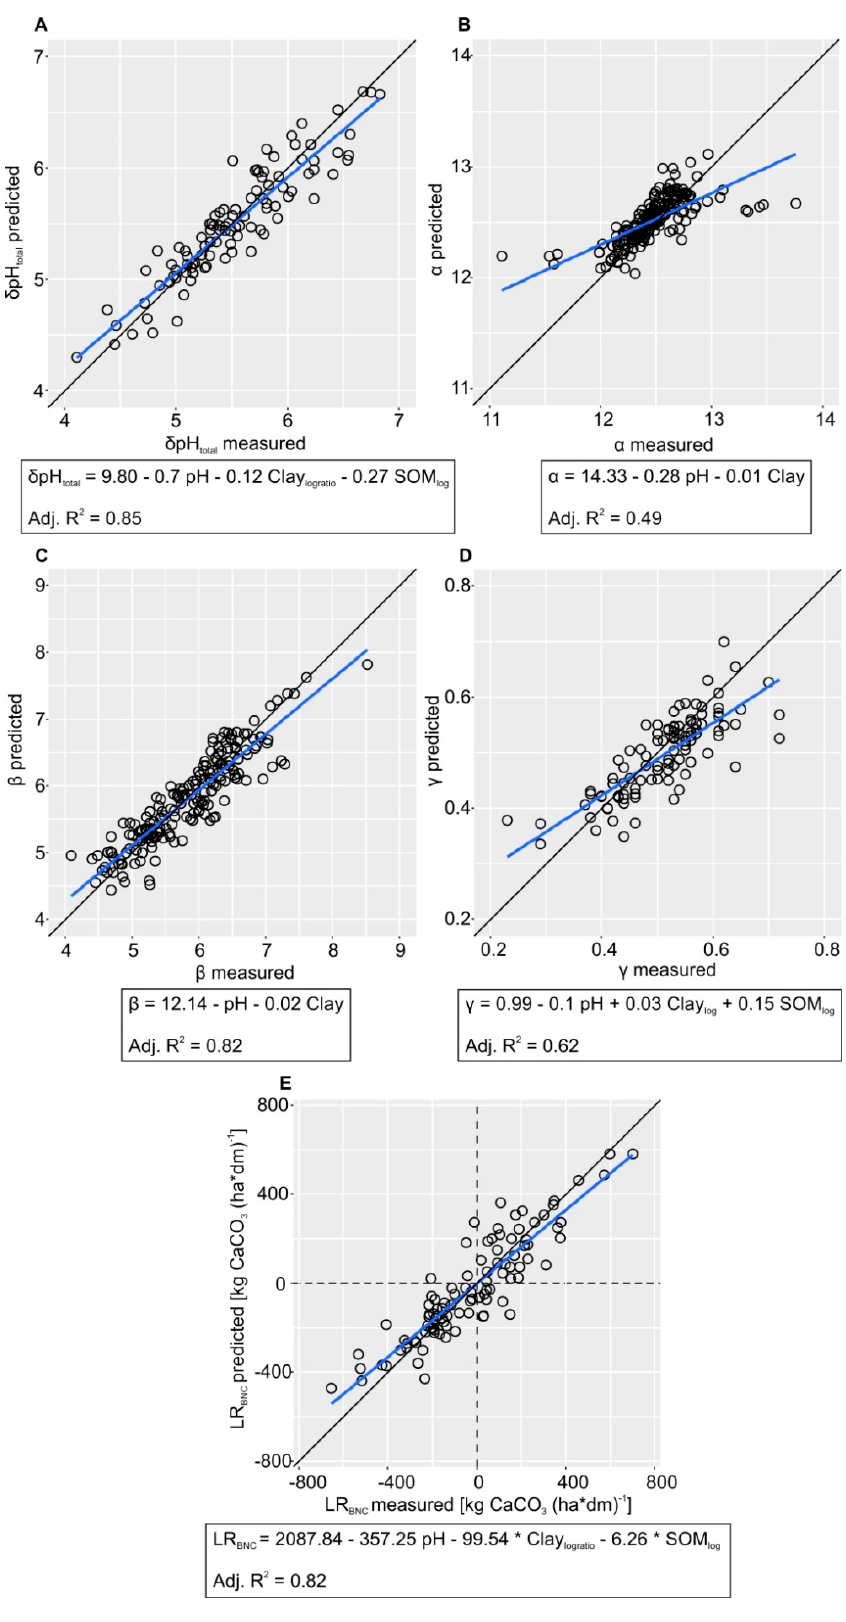
Figure 4. Best-performing multi-variate linear regression (MLR) models in order to predict the BNC parameters ( A ) δ pH total , ( B ) α , ( C ) β , ( D ) γ and ( E ) LR BNC (Clay logratio —log-ratio-transformed clay content, SOM log —log-transformed SOM content).